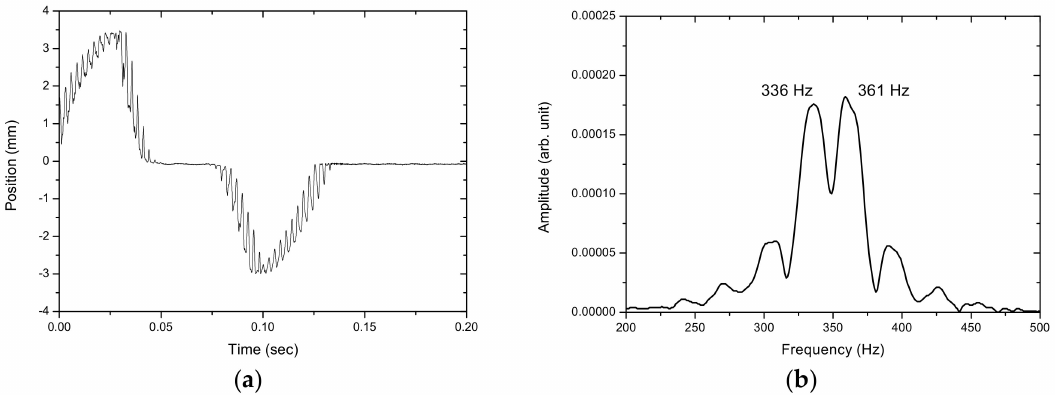
Figure 14. ( a ) The PSD-detected signal and ( b ) the frequency spectrum of the motion of the vibrating string at 5.7 × 10 − 2